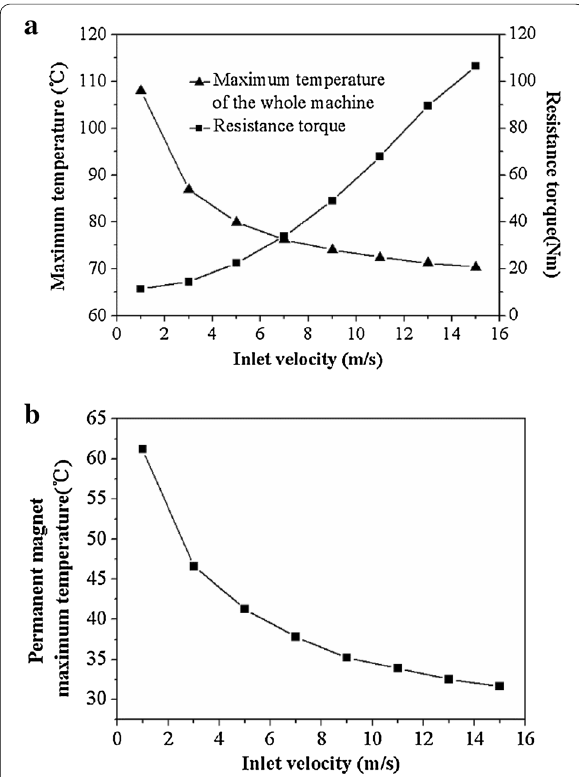
Figure 10 Temperature rise, drag torque under different inlet velocities